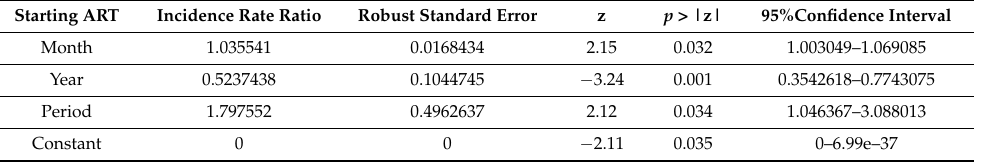
Table 5. Clients starting ART before and during the COVID-19